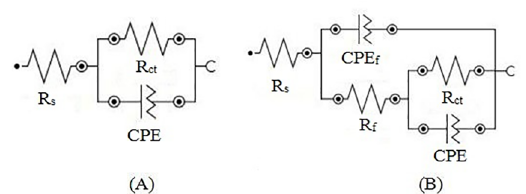
Figure 6. Equivalent circuit models used to simulate the EIS data of (A) the bare carbon steel substrate; (B) the Cu-Sn